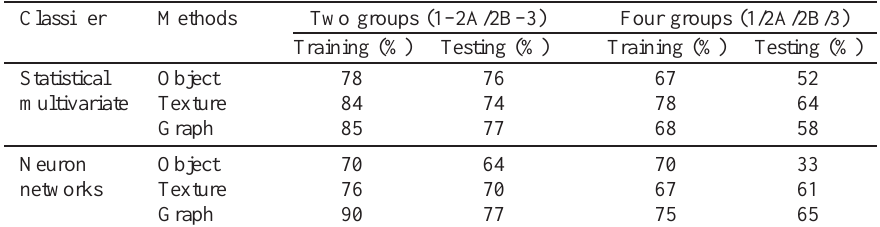
Table 2 Reproducibility from the first to the second set of regions of interest in material II for